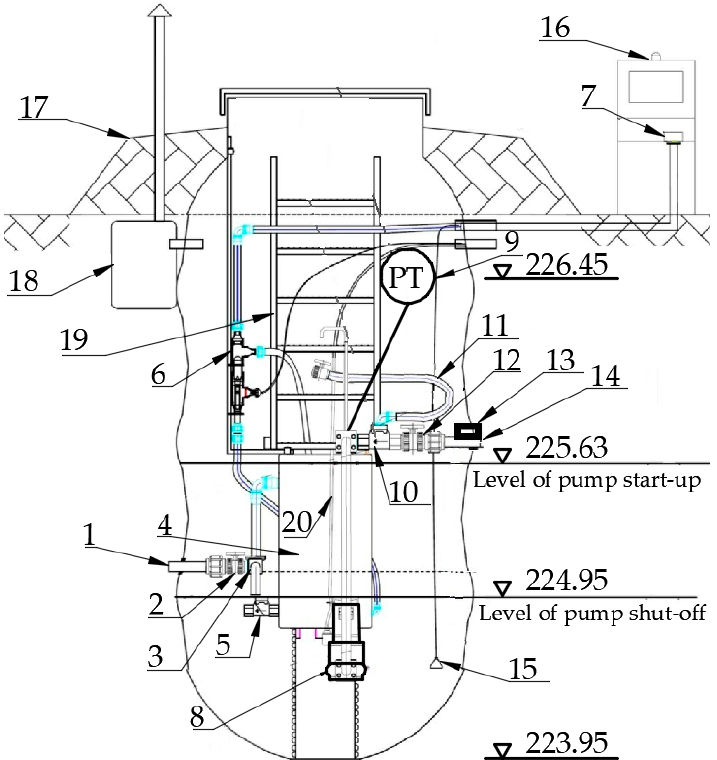
Figure 4. Wastewater pumping station PS_1 according to the design project. Legend: 1—Inlet PE 63